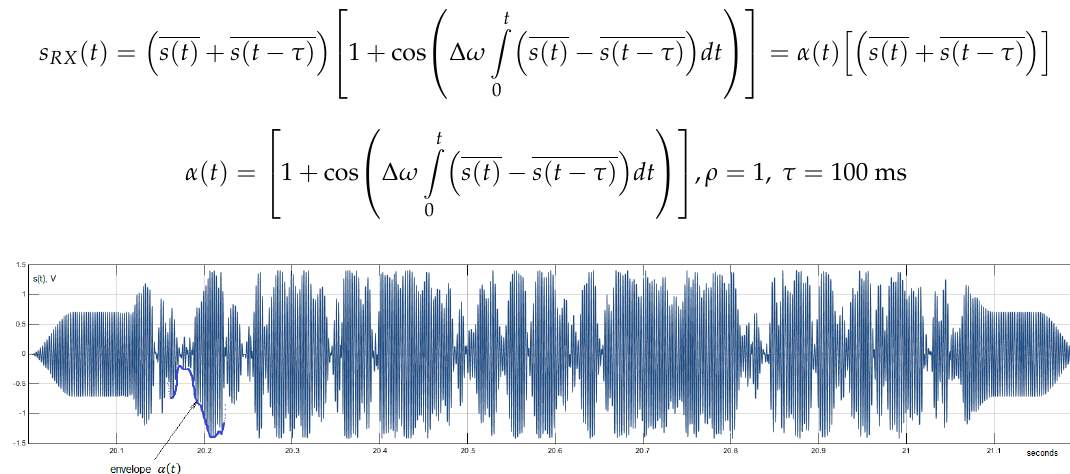
Figure 2. A fragment of the FM-OFDM symbol in the presence of a strong reflected signal component.